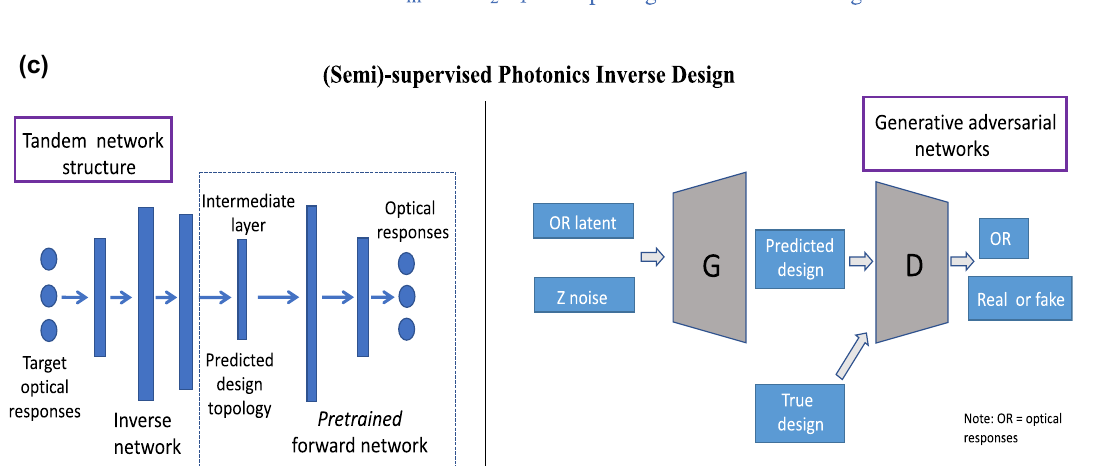
Figure 1: PC nanobeam laser cavities used in this work for inverse design and optimization via deep reinforcement learning and an overview of existing deep learning-based inverse design models. (a) 3D visualization of a typical long PC nanobeam and its top view. (b) 3D visualization of a typical short L3 nanocavity nanobeam and its top view. Indium Phosphide (InP) is chosen as the semiconductor laser material (i.e., the gain material). Physical configurations and optical characteristics of both nanobeams are shown in Table 1. Both nanobeams possess perfect symmetry both laterally and is the x -coordinate of the i th air hole counting from the inside in the taper region and x is the x -coordinate of the holes in the mirror longitudinally. x i m region. (c) Existing (semi)-supervised models for photonics inverse design, which takes target optical responses as input and outputs retrieved design parameters. Left: a tandem neural network structure built with MLPs, where the boxed region represents the pre-trained forward network. Right: a GAN-based model that is able to distinguish predicted design parameters from ground truths. This method is unable to perform optimization of the photonic structure. G and D in the figure denote the generator and discriminator, respectively. This work will address the flaws inherent in these DL models shown here. A detailed comparison between the method proposed in this work and existing DL methods can be found in the Supporting